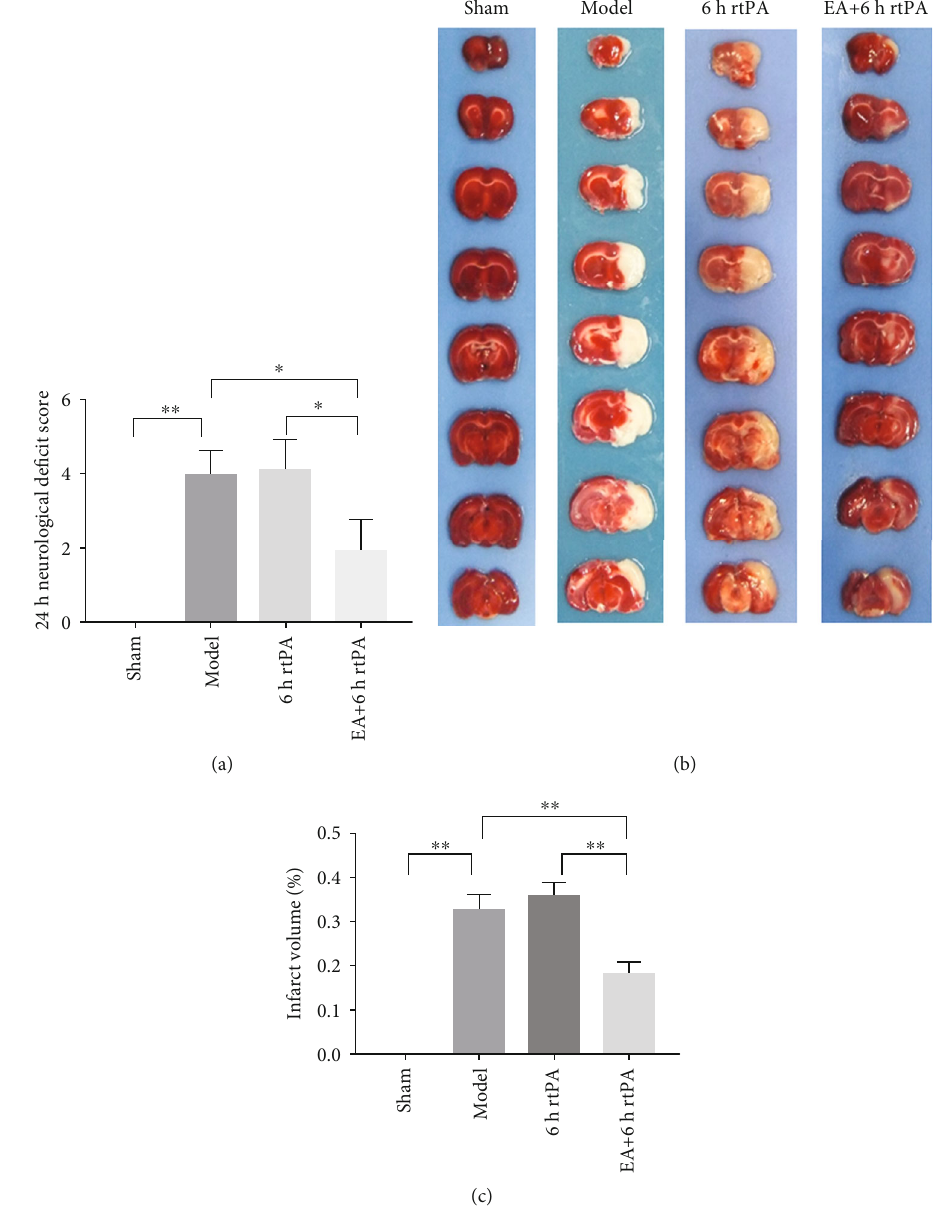
Figure 1: The neurological de fi cit score ( n = 10 rats) and infarct volume ( n = 6 rats) in each group. (a) Neurological de fi cit score. (b) Representative images of brain slices stained with TTC. (c) Brain infarct volume. ∗ indicates p < 0 : 05 ; ∗∗ indicates p < 0 : 01